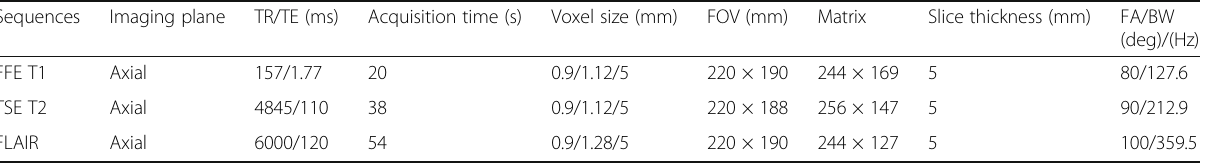
Table 1 Imaging parameters of the basic MR sequences